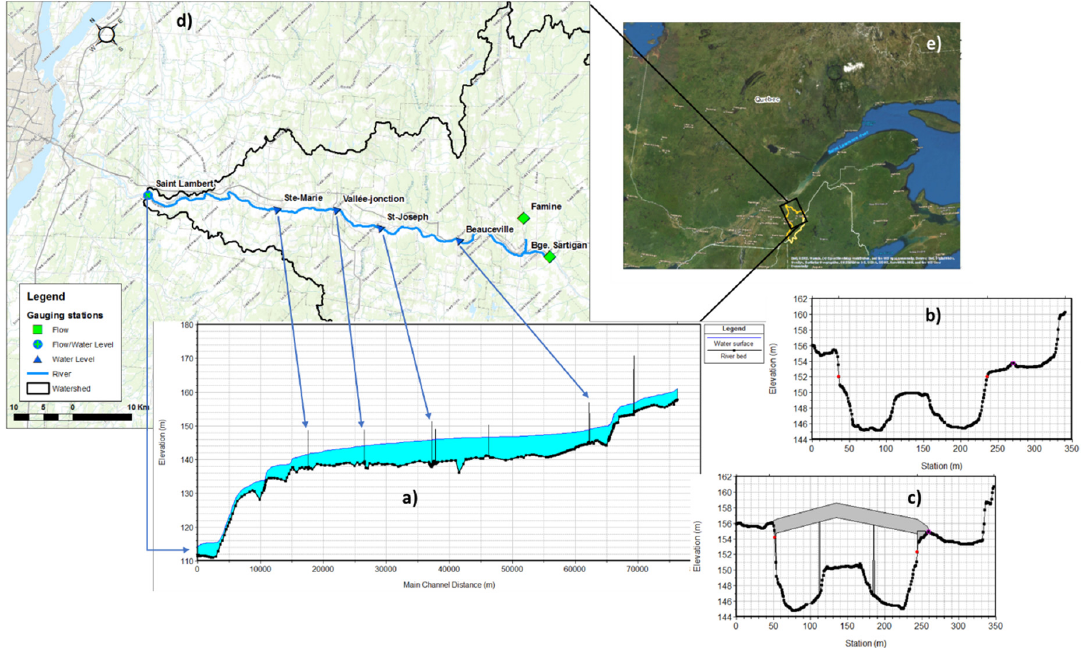
Figure 1. Location and geometry of the Chaudière River: ( a ) longitudinal profile of the river, ( b ) sample cross section of the 1D river model, ( c ) sample of the hydraulic structures included in the river model, ( d ) World Topographic Map—Sources: Esri, HERE, Garmin, Intermap, increment P Corp., GEBCO, USGS, FAO, NPS, NRCAN, GeoBase, IGN, Kadaster NL, Ordnance Survey, Esri Japan, METI, Esri China (Hong Kong), ( c ) OpenStreetMap contributors, and the GIS User Community, and ( e ) World Boundaries and Places–Esri, HERE, Garmin, ( c ) OpenStreetMap contributors, and the GIS user community. World Imagery–Source: Esri, DigitalGlobe, GeoEye, Earthstar Geographics, CNES / Airbus DS, USDA, USGS, AeroGRID, IGN, and the GIS User